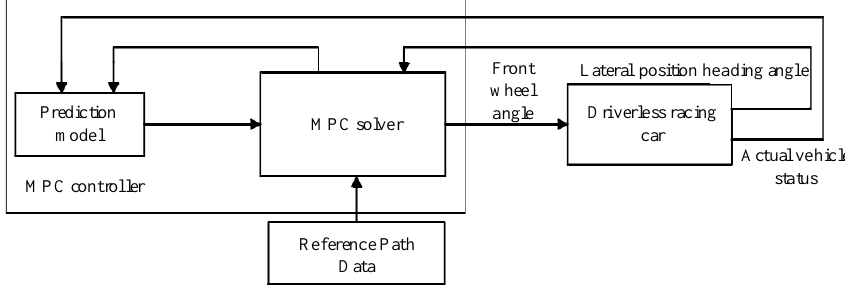
Figure 5. Coordinated control of lateral control and longitudinal control.